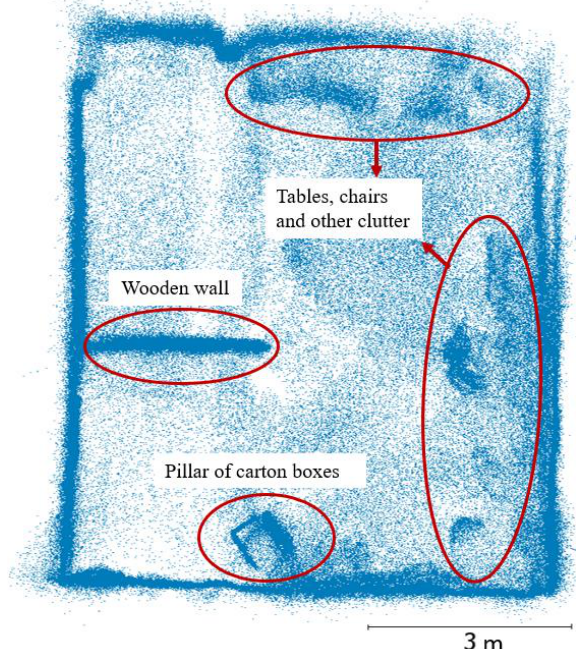
Figure 3. Top view of the MAX Kiwi map (3D point cloud) for the Berrozi dataset.